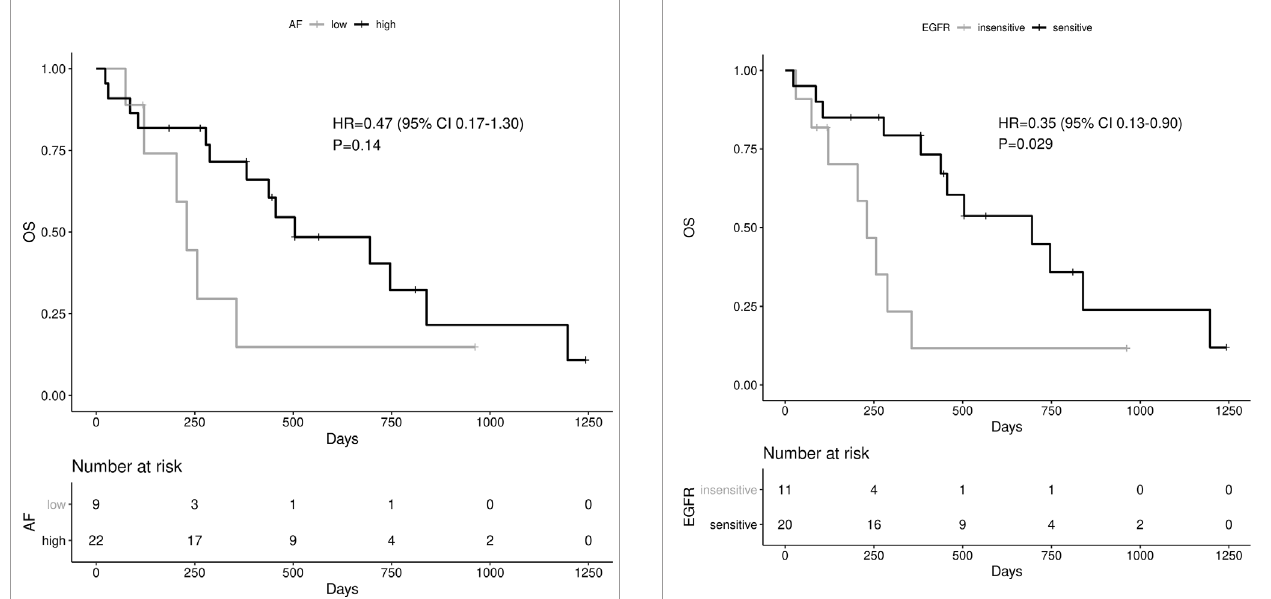
FIGURE 2 | Impact of EGFR allele frequency on OS.